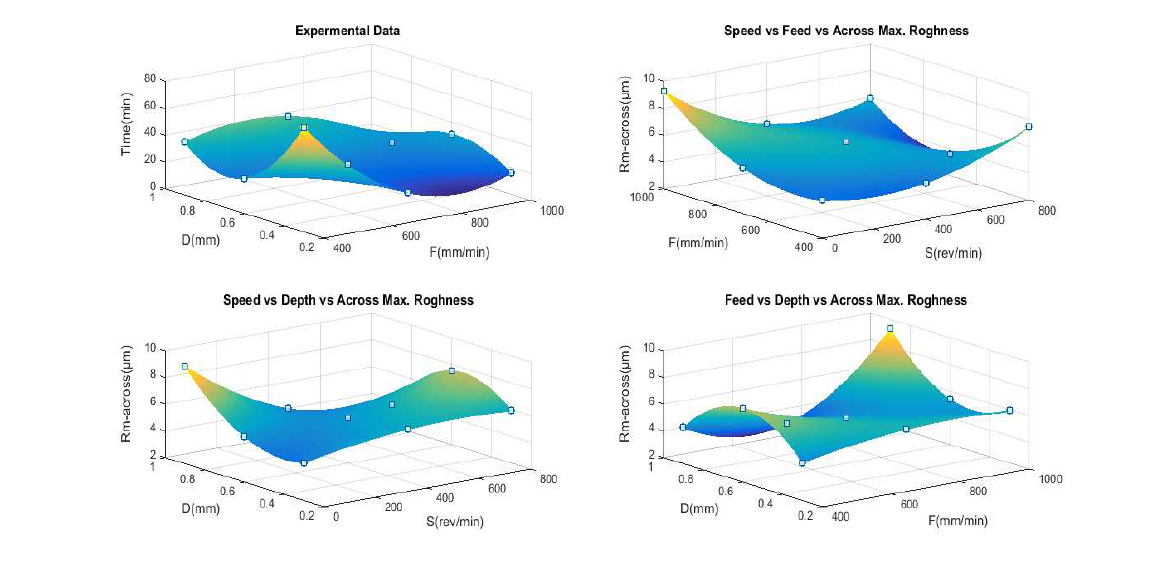
Fig. 6. The relationship of maximum roughness (across) with respect to process variables.